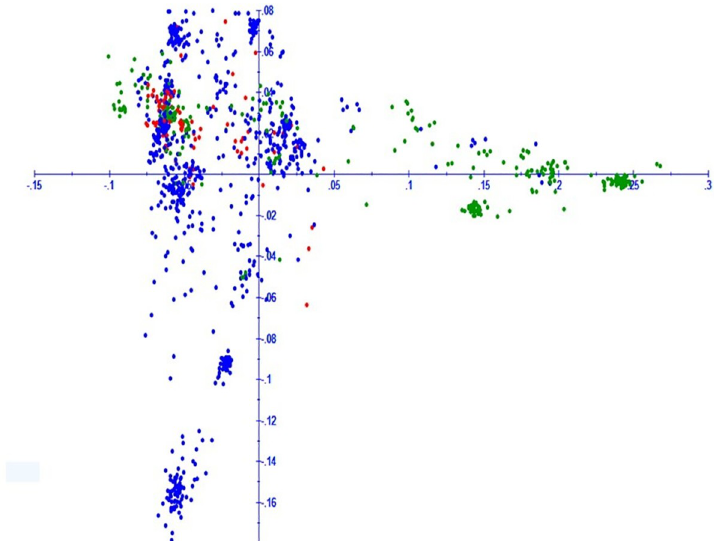
Fig 5. Two dimensional PCA plot sowing grouping of Mexican landraces from three regions determined through DArT-seq SNP markers. Landrace accessions belonging to northern, central and southern Mexican states are depicted as green, blue and red dots, respectively, in the graph.